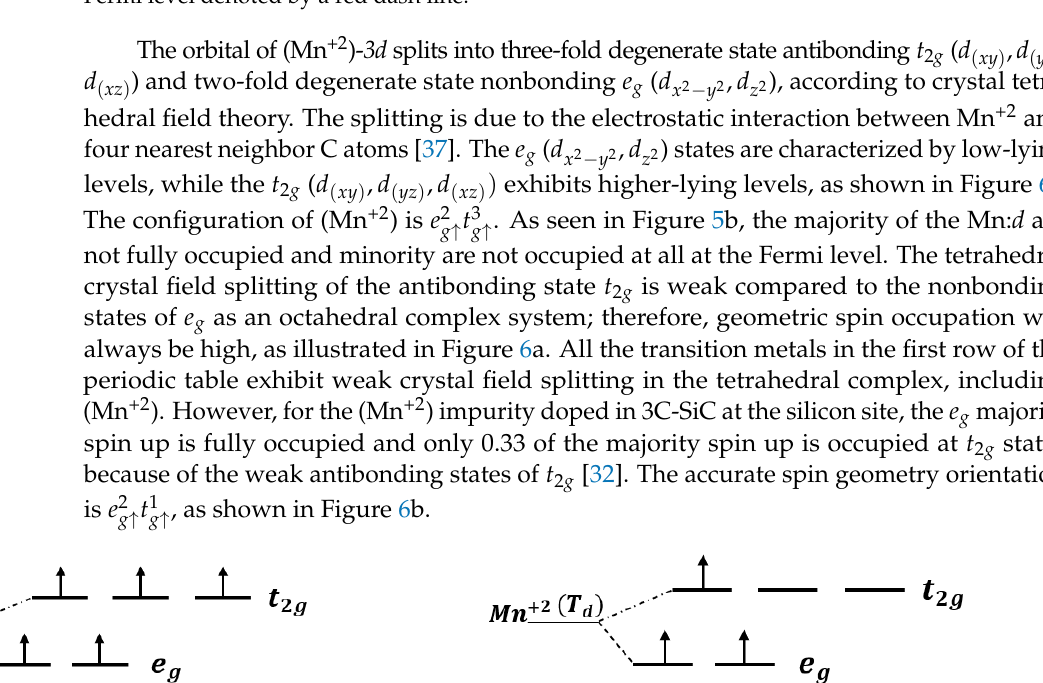
Figure 5. Spin polarized ( a ) total density of state (TDOS) and ( b ) partial DOS of (Mn +2 )-doped 3CSiC. Fermi level denoted by a red dash line.